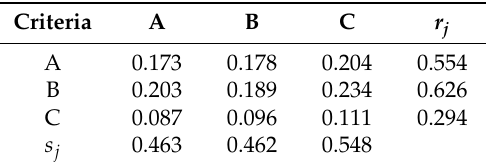
Table 10. Total dimensions relation matrix.